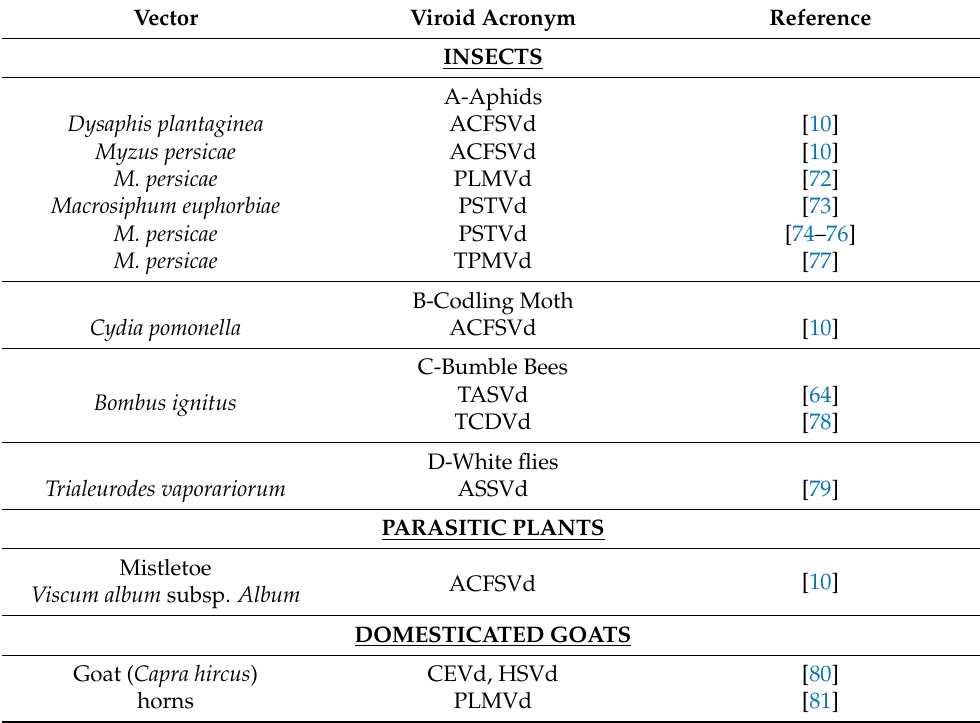
Table 2. Insects, Parasitic Plants and Goats Transmission of